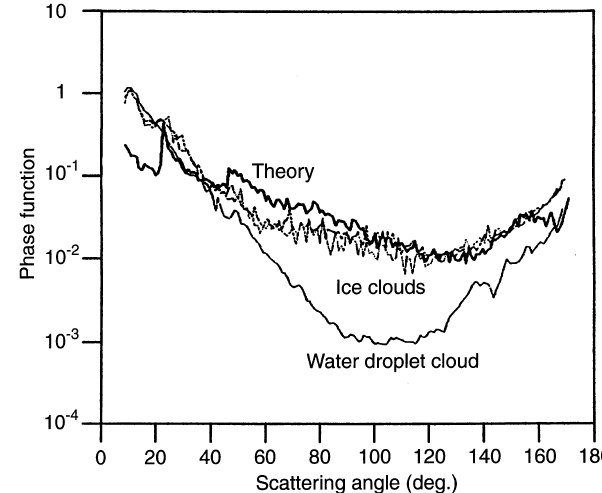
Fig. 6. Ice crystal number concentrations from Fig. 6 multiplied by the appropriate ice crystal area